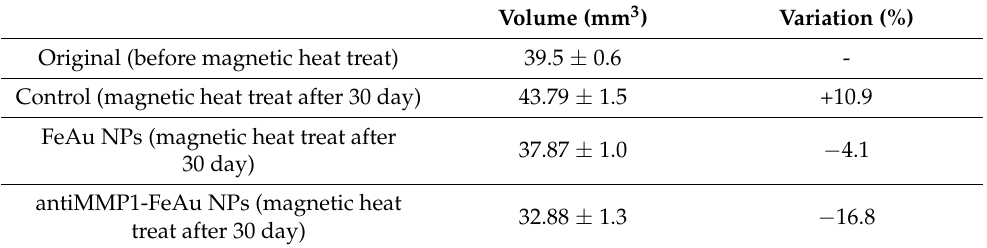
Table 3. Tumor volume change in animal study by magnetic hyperthermia